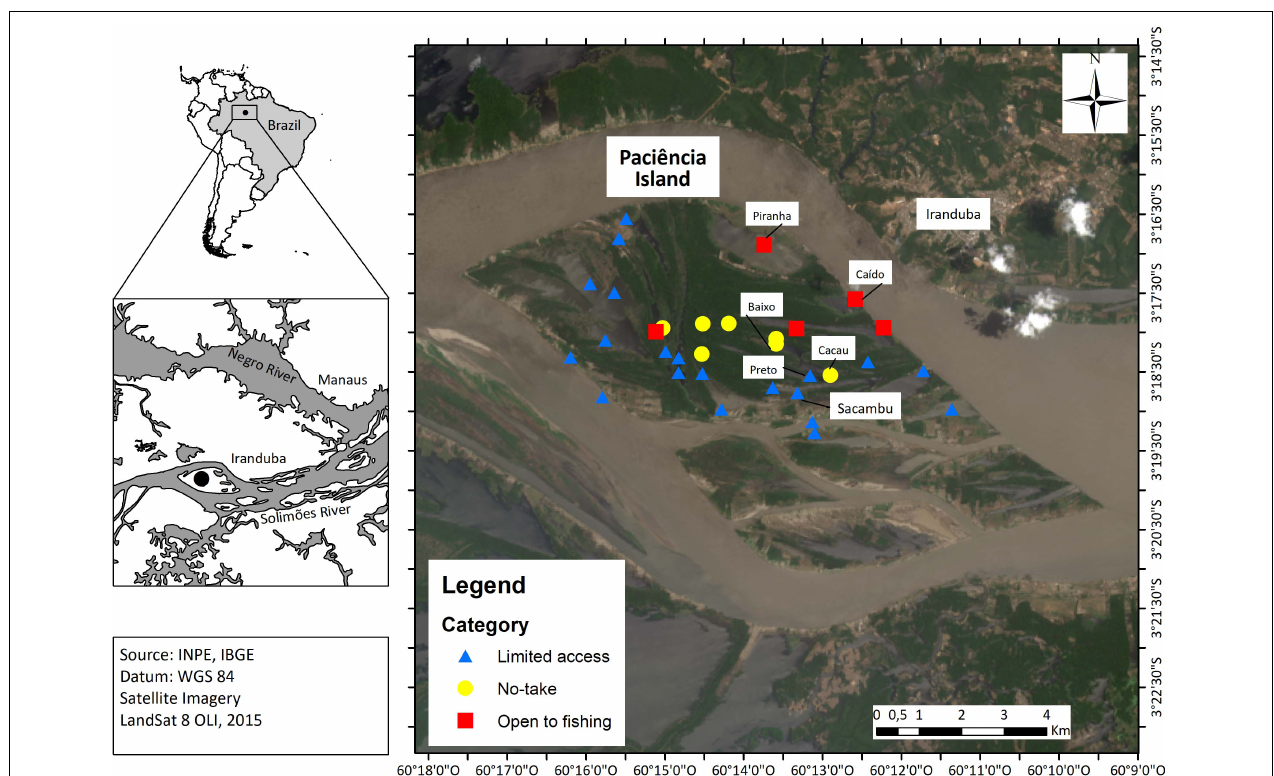
FIGURE 1 | Study area showing the sampling lakes per category of management regime on the Paciência Island (Amazon Basin,